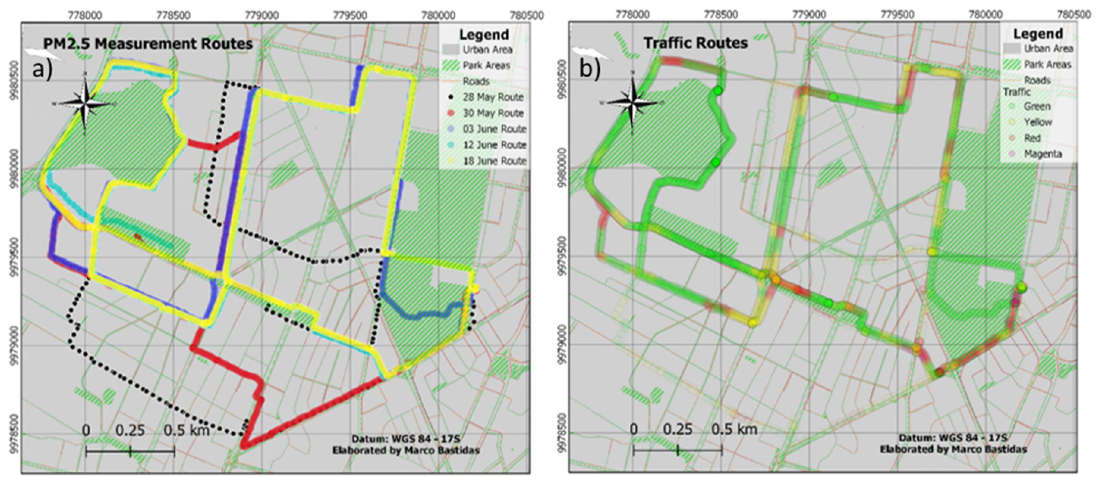
Figure 4. Study area maps: ( a ) the paths in the study perimeter for different dates of measurements; ( b ) real traffic measurements based on the register of Google Traffic application for 3 June 2019, overlapped with the typical traffic in central Quito.